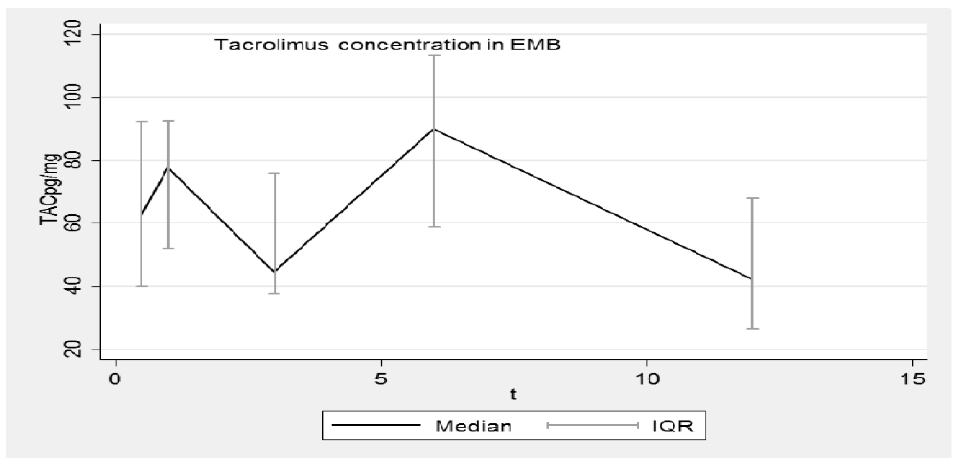
Figure 2. Median concentration–time profile of TAC in EMBs. TAC: Tacrolimus; EMB: Endomyocardial biopsy; IQR: interquartile range.